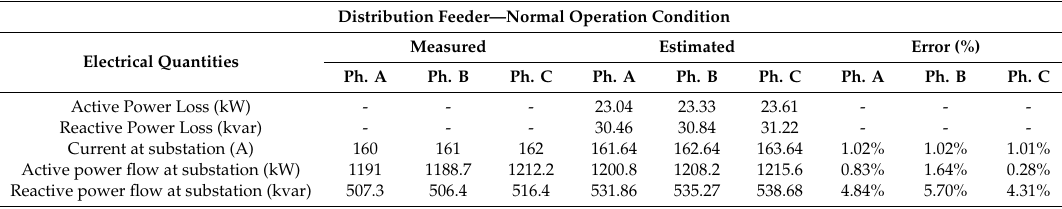
Table 1. Result for estimated system losses and comparison between measured and estimated data at the substation.